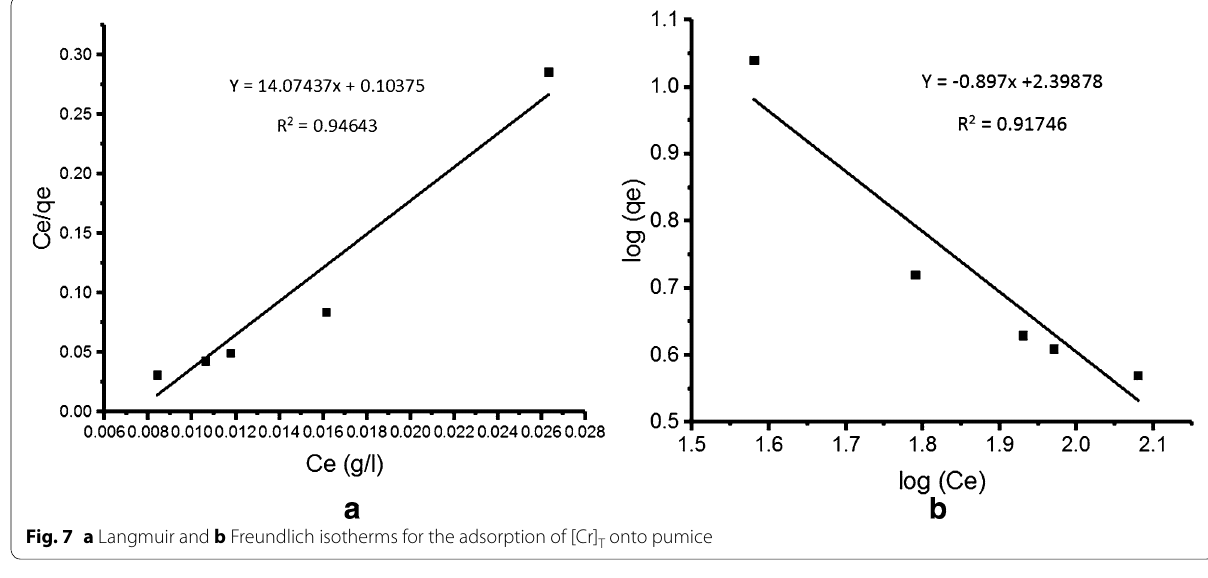
Fig. 7 a Langmuir and b Freundlich isotherms for the adsorption of [Cr] T onto pumice